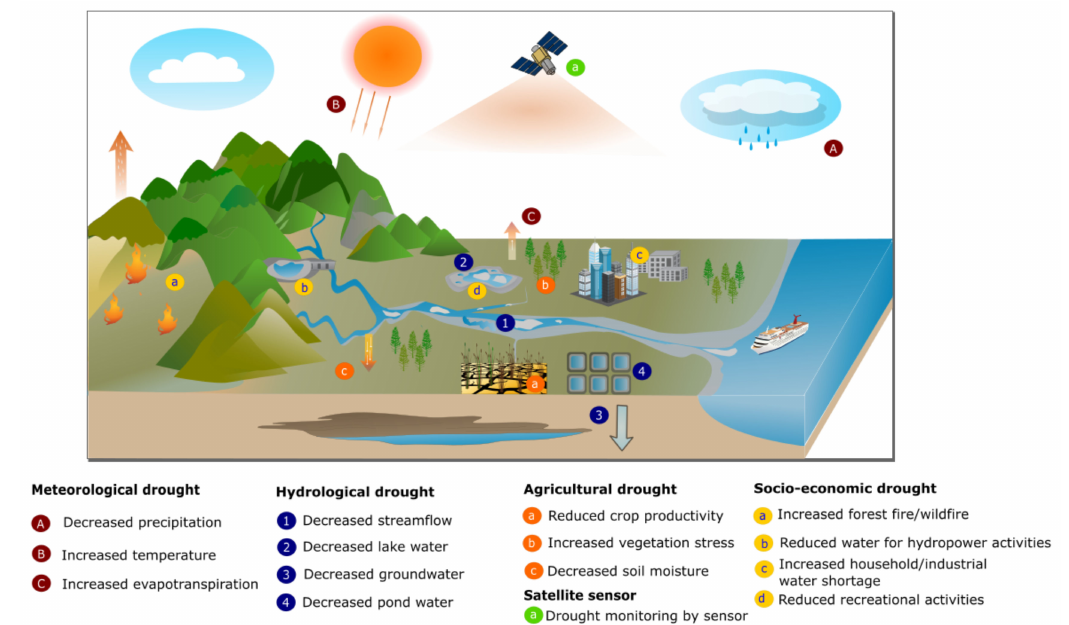
Figure 1. An overview of the drought types and their associated factors and impacts on land features, such as increased crop failure and vegetation stress. This figure is intended to provide a general overview of the main drought types, impacts and responses, as drought conditions may vary from place to place; consequently, their impacts and responses vary. Most of symbols were extracted from the University of Maryland (https://ian.umces.edu/, last accessed on 5 May